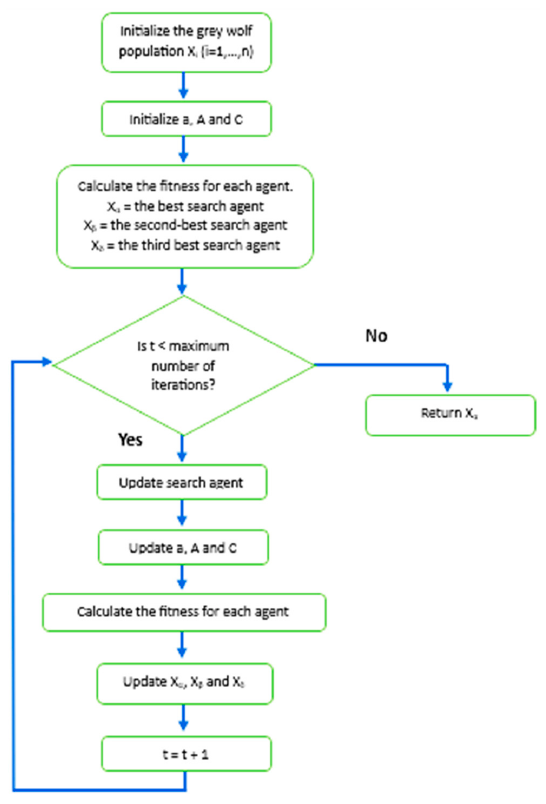
Figure 4. The GWO Figure 4. The GWO algorithm.